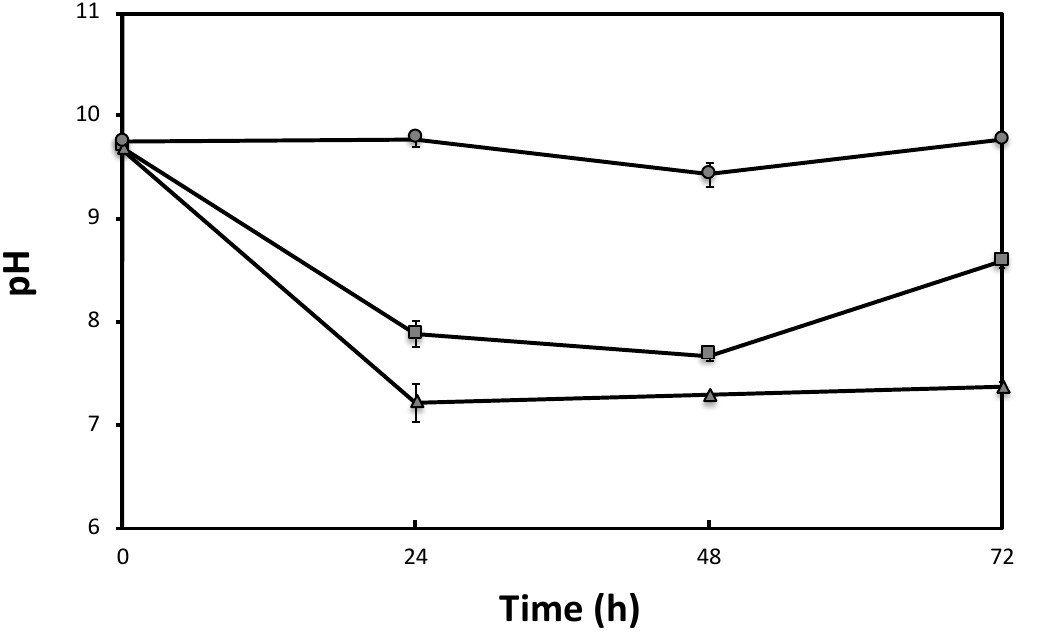
Figure 4. Time course of pH variation in Se IV -treated (2 mM) and untreated cultures of S. bentonitica